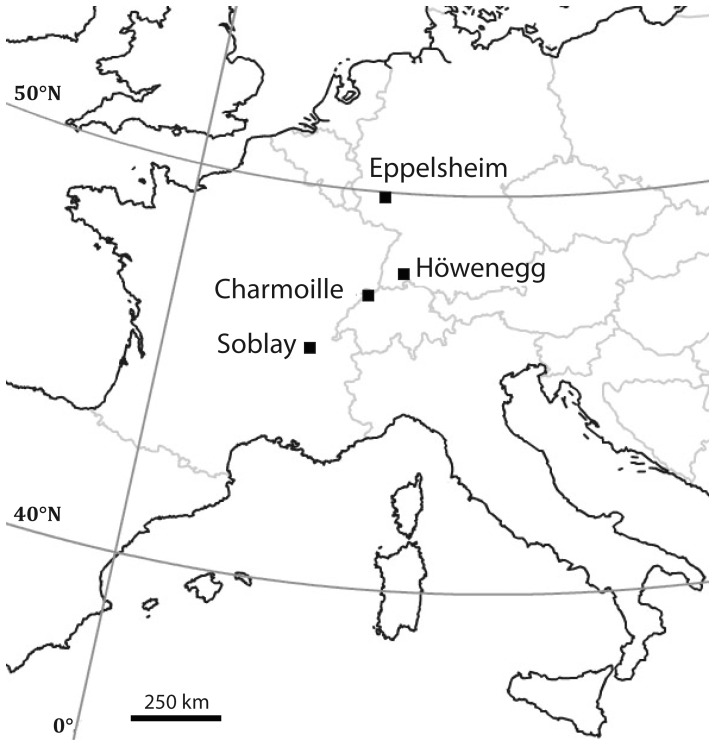
Geographic location of the investigated Late Miocene sampling sites.